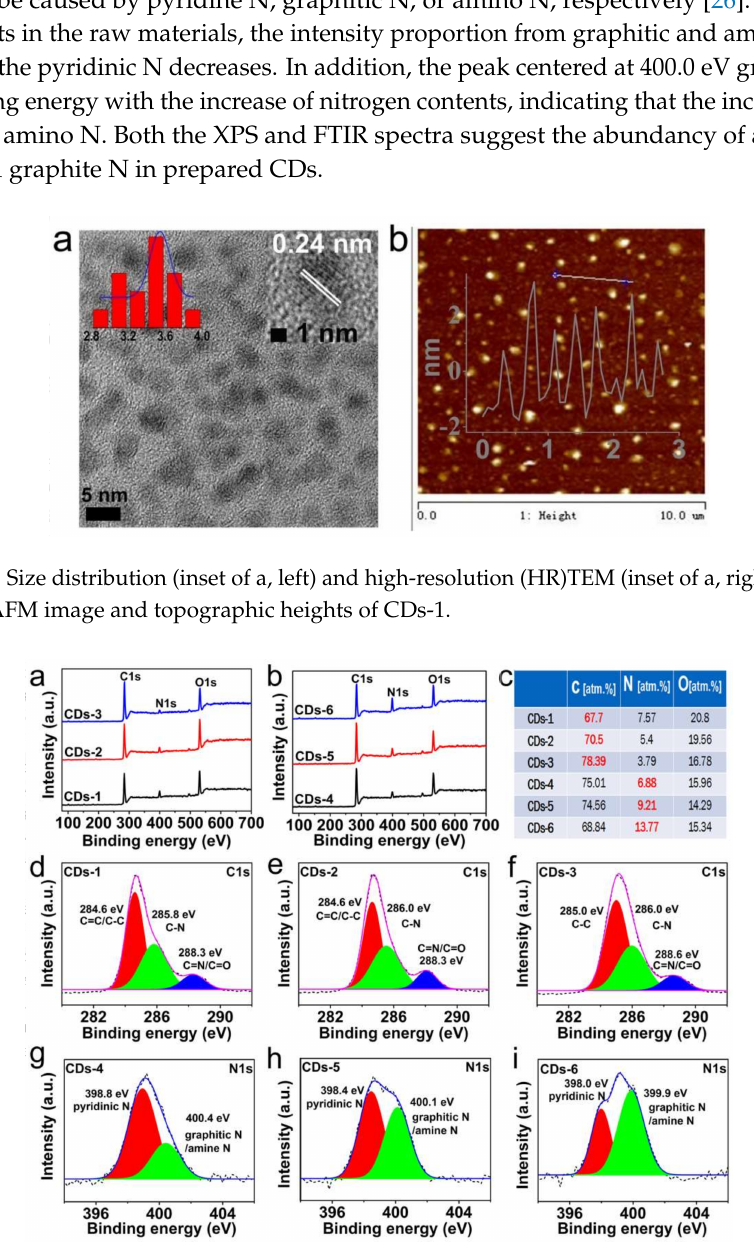
Figure 2. ( a , b ) XPS spectra of CDs-1, CDs-2, CDs-3, and CDs-4, CDs-5, CDs-6; ( c ) The element contents for CDs-1 to CDs-6; ( d – f ) C1s spectra and fitting results of CDs-1, CDs-2, and CDs-3, respectively; ( g – i ) N 1s spectra and fitting results of CDs-4, CDs-5, and CDs-6,